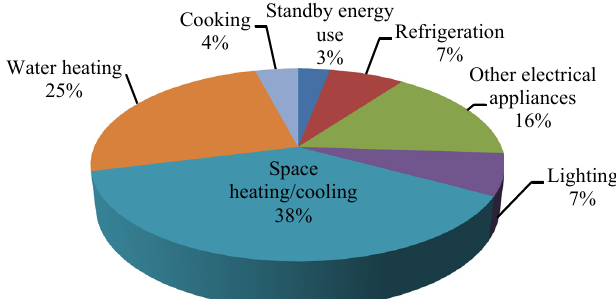
Fig. 1. Breakdown of average energy use in a typical